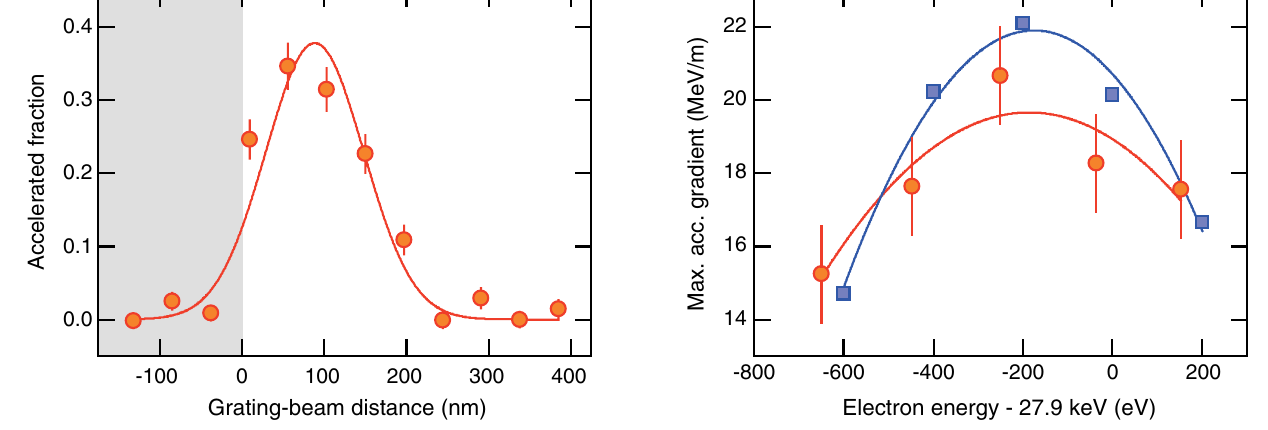
FIG. 12 (color online). Measurement of the accelerated fraction FIG. 13 (color online). Measurement (orange circles) and ab initio simulation (blue squares) of the maximum acceleration versus the distance between the grating surface (shaded area) and the electron beam center, with Gaussian fit (solid curve). This gradient as a function of the initial electron energy, with quadratic measurement has been performed with a laser peak electric field fits as guides to the eye (solid lines). The largest acceleration ¼ 2 . 36 GV = m and at a fixed energy gain Δ E ¼ 30 eV. of E gradient occurs 200 eV below the synchronous energy (27.9 keV) p because the acceleration at the rising edge of the Gaussian-shaped Because of the finite width w of the electron beam, we measure a e interaction, with width w few accelerated electrons even when the beam center lies slightly , ensures synchronicity during the int inside the grating. The absolute position ( z 0 ¼ 0 ) of the data presence of the laser peak electric field. The slight difference between the curves ’ width requires further investigation. The relative to the grating surface has been determined from simu- experimental values have all together been shifted by − 340 eV to lations [Eq. (8)]. match the simulation results ( − 260 eV due to field penetration (Fig. 7) and − 100 þ 100 − 570 eV due to angular misalignment of the